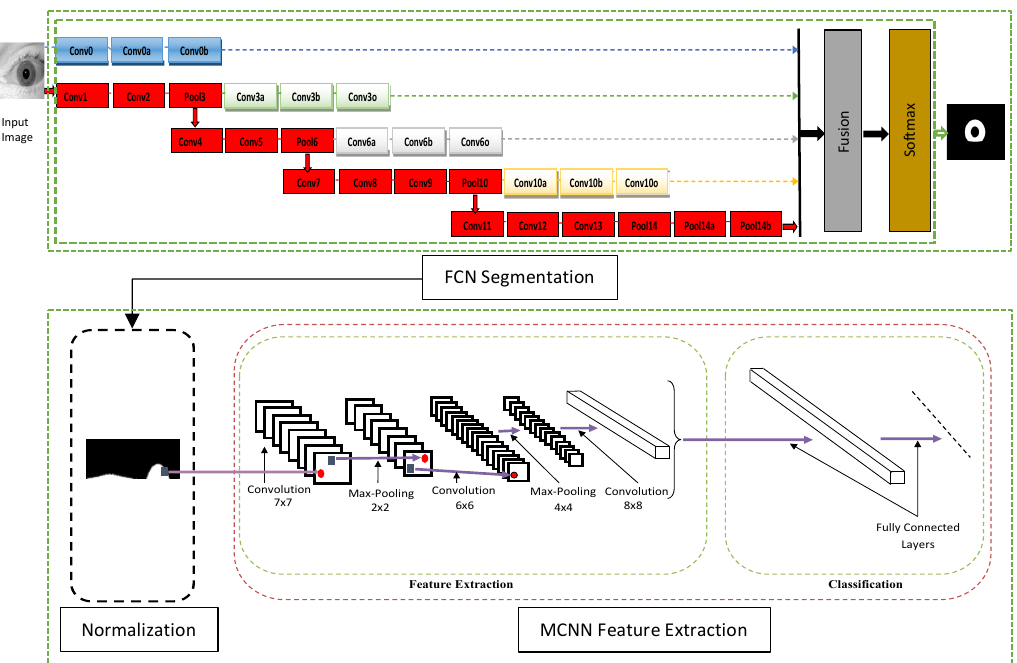
Figure 1. The framework for iris recognition using FCN segmentation then Normalization, feature are next extracted by using